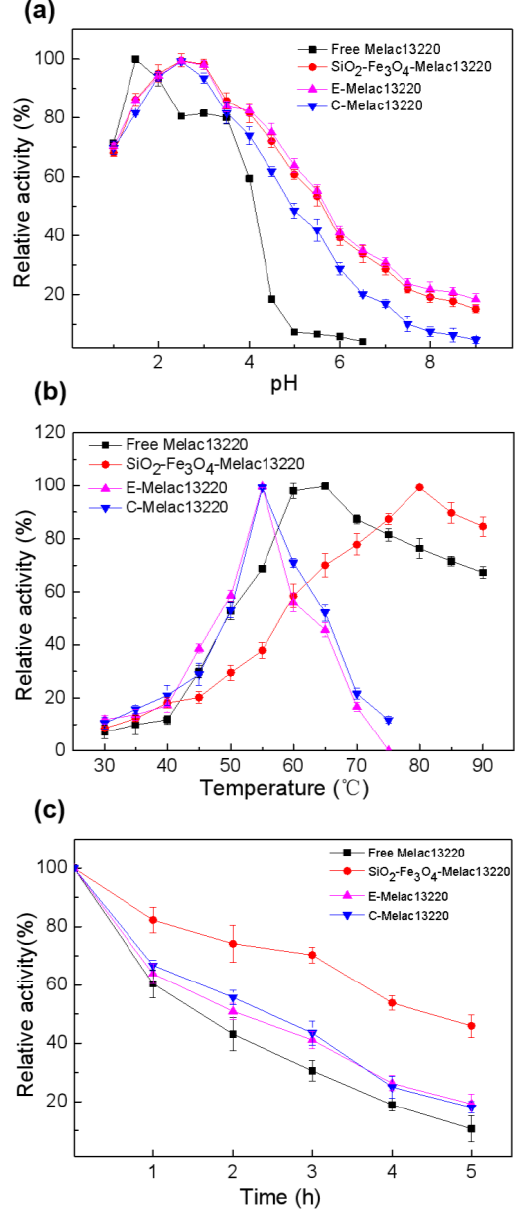
Figure 5. Effect of pH ( a ), temperature ( b ) on the activity and thermostability ( c ) of the free and immobilized Melac13220. All the results are represented as the means ± standard deviation from at least three independent experiments.